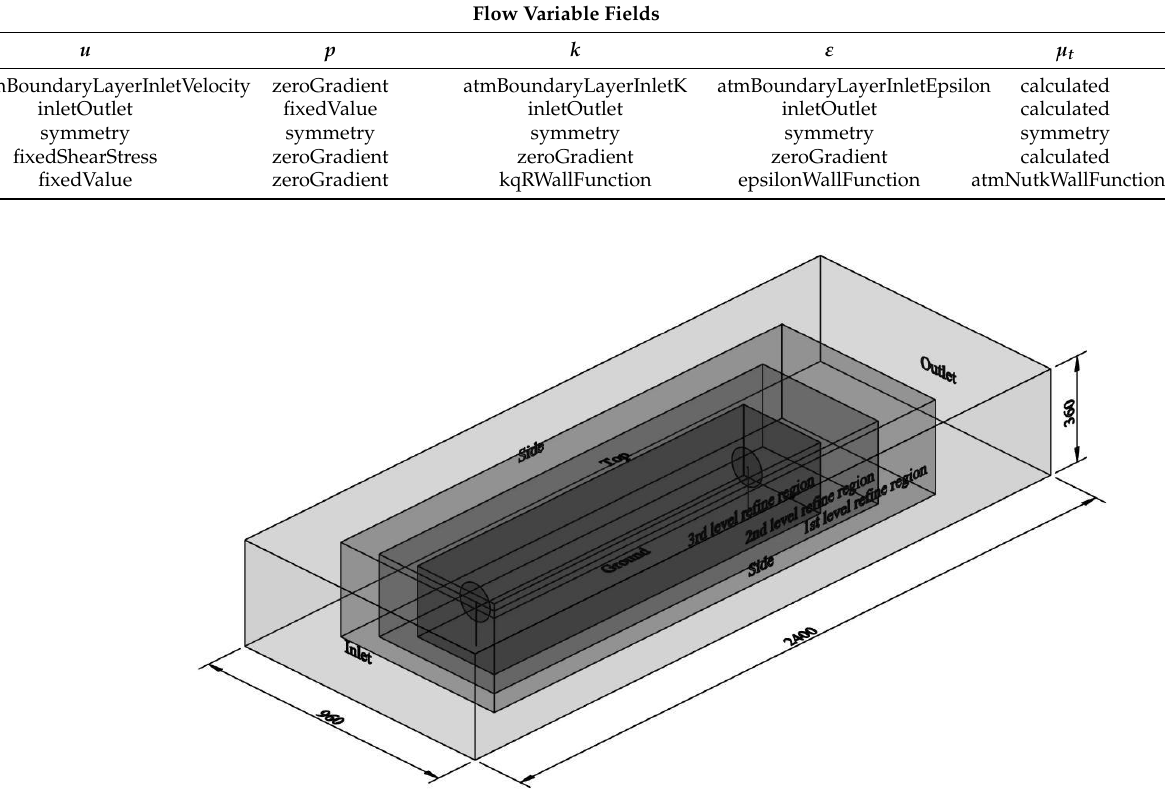
Figure 2. A sketch of the computational domain and the mesh refinement scheme(unit, m).